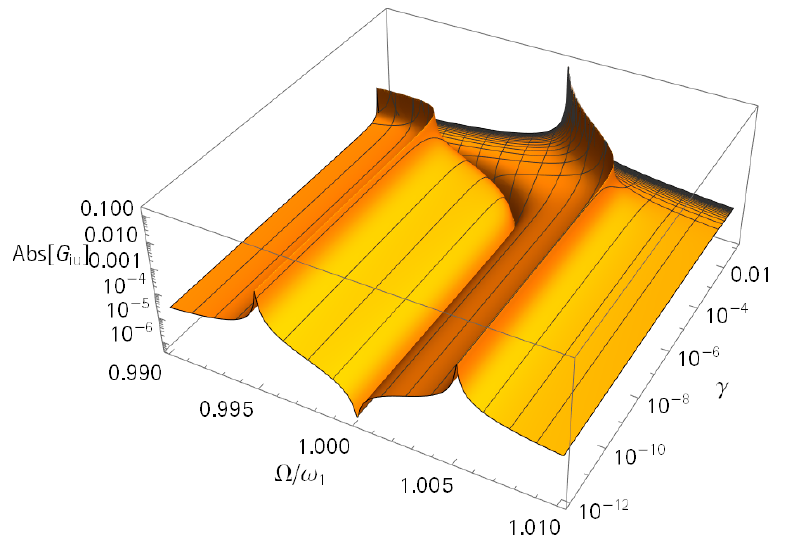
Figure 8. Magnitude of the admittance ( (cid:1833) (cid:2919)(cid:2905) ) for varying (cid:2011) values. The used parameters were m = 1 kg; m n = (cid:2011)(cid:1865) ; k = 10 N/m; M = (cid:1865)/(cid:2018) ; k M = (cid:1863)/(cid:2018) ; (cid:2018) = 10 − 4 ; D = d M = 5 × 10 − 4 Ns/m; C p = 10 nF; and α = 0.1 N/V.